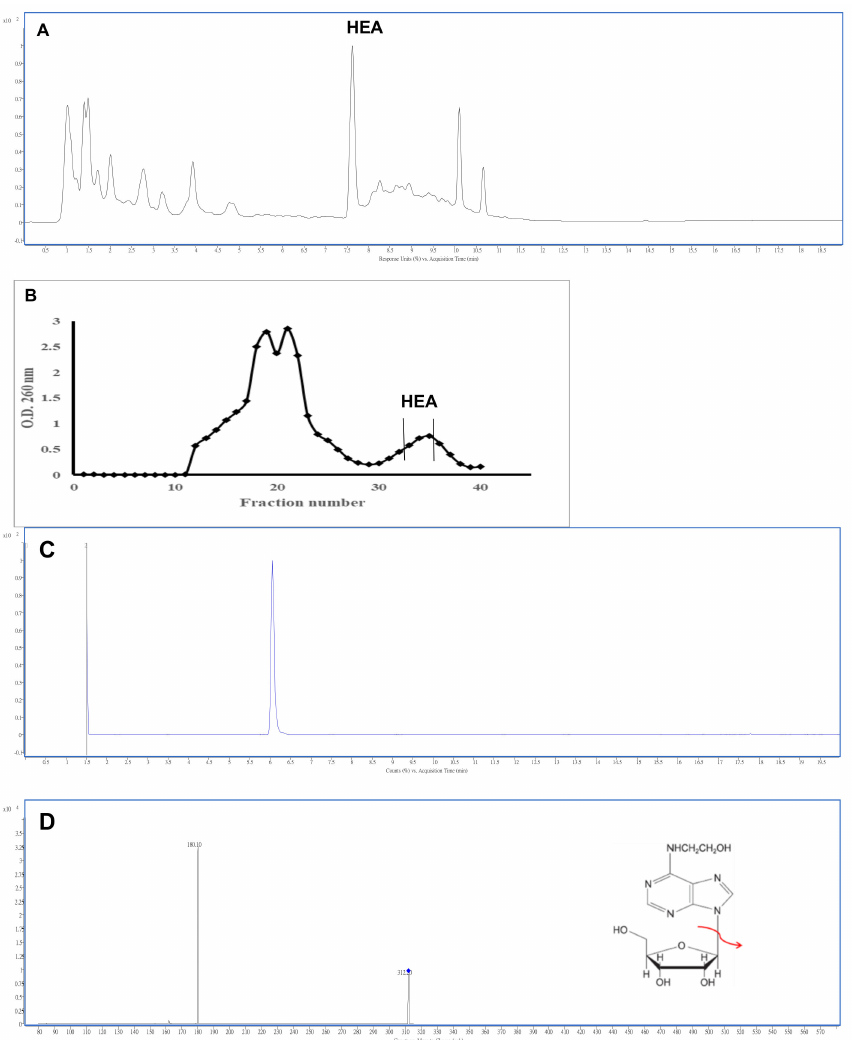
Figure 1. High performance liquid chromatographic analysis of the prepared C. cicadae mycelia extract (CCM-2). ( A ) fractionation chromatogram from CCM-2 by gel permeation chromatography Sephadex LH-20. HEA mostly emerged in fractions 33–35. ( B ) total ion chromatogram of HEA ( C ) and the mass spectrum ( D ) of purified N 6 -(2-hydroxyethyl)adenosine (HEA) from C. cicadae mycelia extracts; → : m / z 180 from the MS fragmentation of parent ion 312 in MS/MS